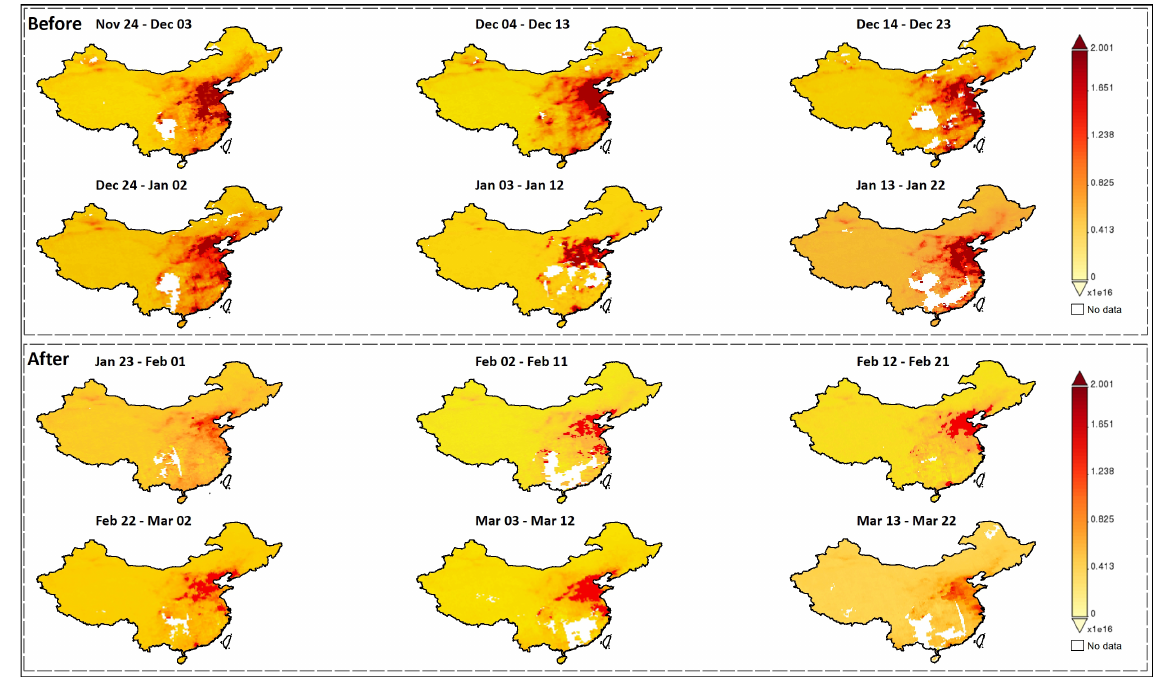
Figure 1. Spatial distribution of 10-day time-average map of NO 2 tropospheric column of China before (24 November 2019 to 22 January 2020) and after the pandemic (23 January to 22 March 2020). Source: OMI, Global Modeling and Assimilation Office, NASA, 2020.